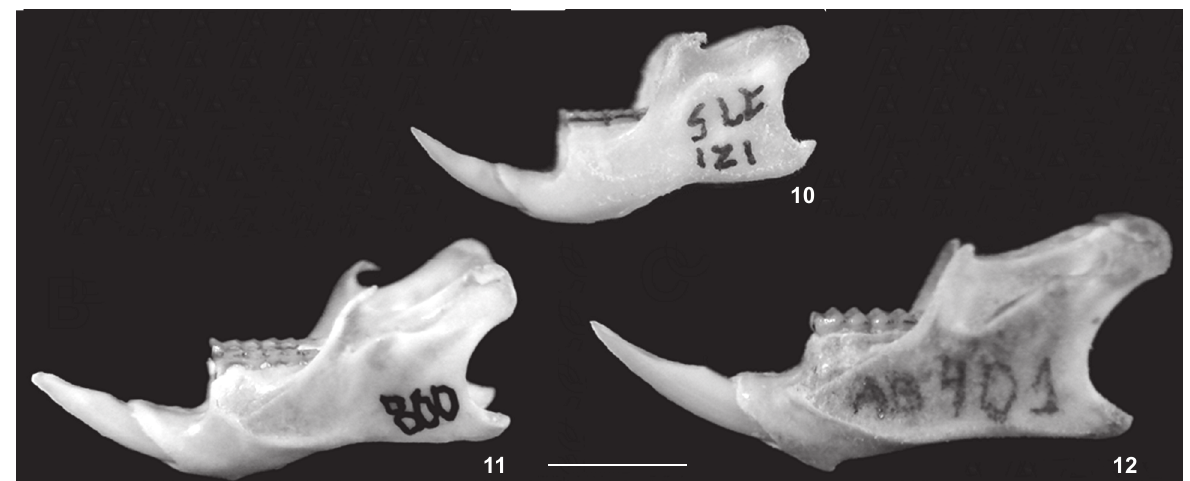
Figures 10-12. Lateral view of the mandibles of: (10) Oligoryzomys flavescens (UFES 1177); (11) Juliomys pictipes (UFMG 3165); (12) Rhagomys rufescens (AB 401). Scale bar = 5 mm.